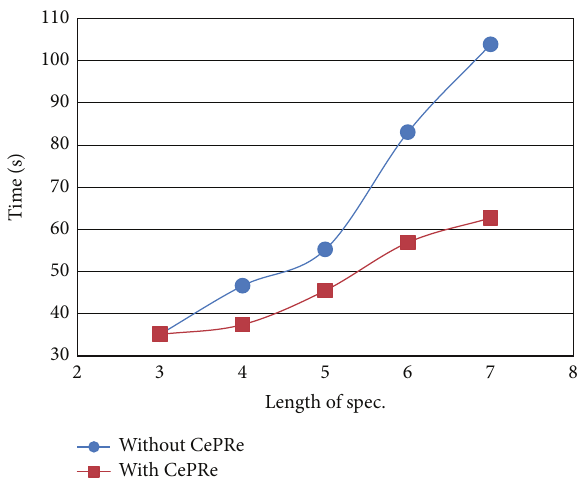
Figure 5: Time overhead in random BMC experiments.